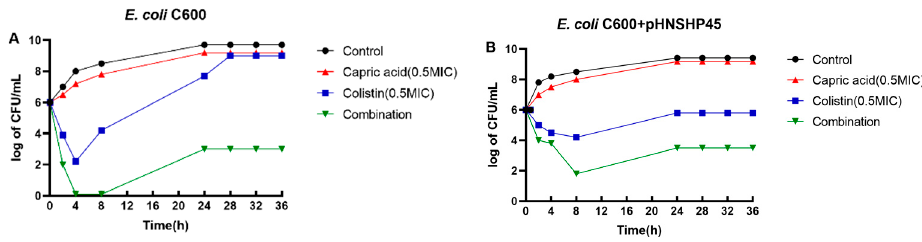
Figure 1. Time-kill study performed with E. coli C600 ( A ) and E. coli C600 + pHNSHP45 ( B ) with colistin monotherapy (0.5 × MIC), capric acid monotherapy (800 mg/L), and their combination colistin monotherapy (0.5× MIC), capric acid monotherapy (800 mg/L), and their combination (equivalent (equivalent concentrations).